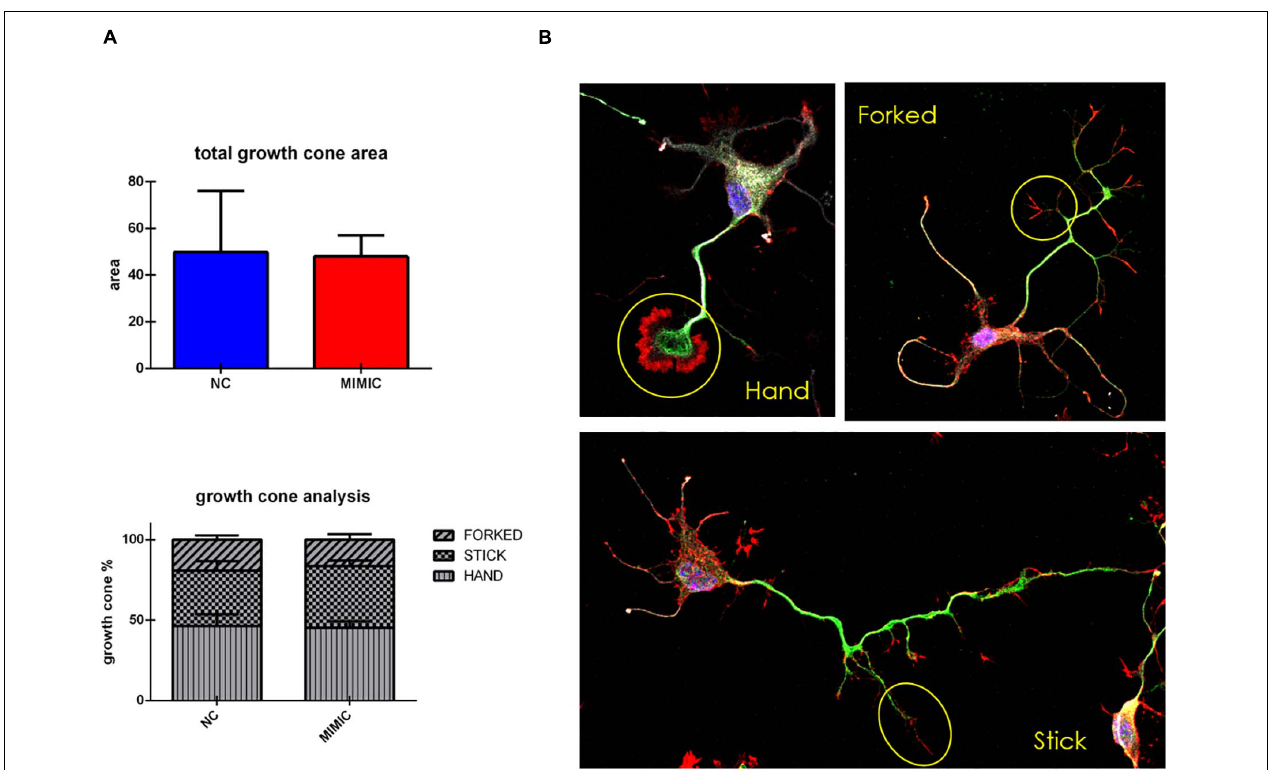
FIGURE 7 | Growth cone analysis in cortical neurons overexpressing miR-7b-3p. (A) Measurement of the growth cone area and the percentage of “hand,” “forked,” and “stick” growth cone shape in mimic transfected cells. (B) “hand,” “forked,” and “stick” growth cone shape analysed in cortical neurons with SMI-32 (neurofilament in white), β III-tubulin (cytoskeleton in green), phalloidin (actin in red). Scale bar: 20 µ m. The graphs express the area and the percentage of each type of growth cone/total growth cone number ± SEM ( n = 5; t -test